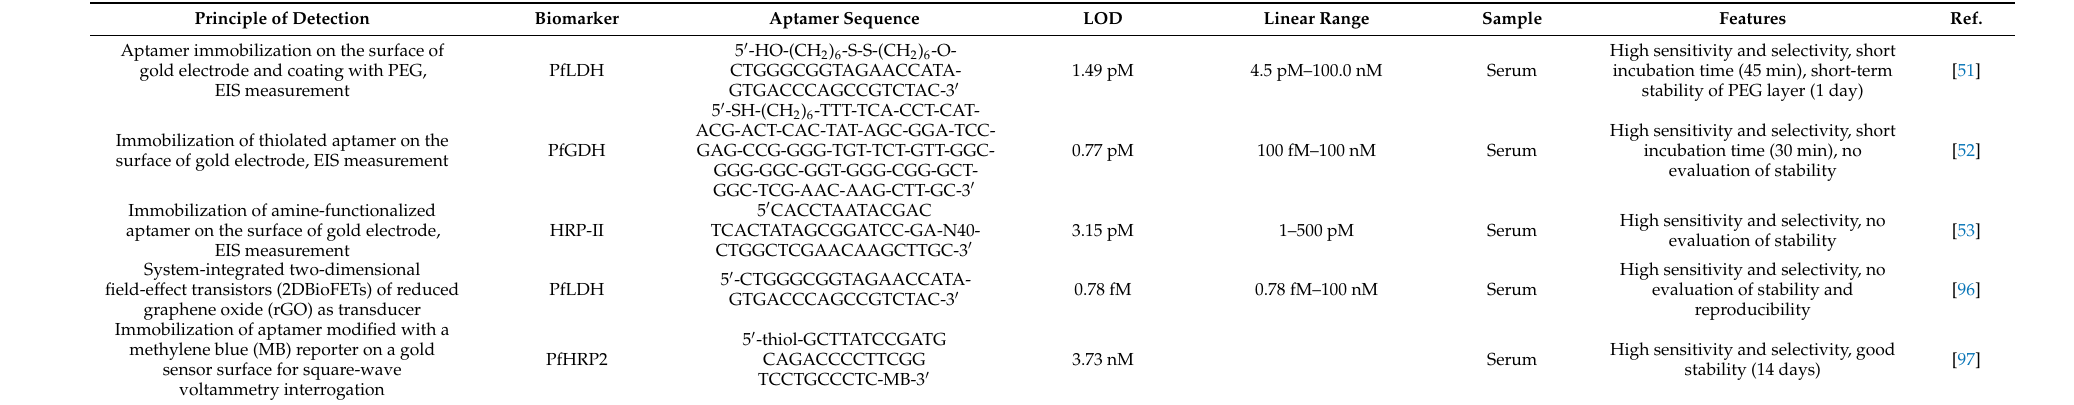
Table 5. Recent advances in electrochemical aptasensors for the detection of malaria